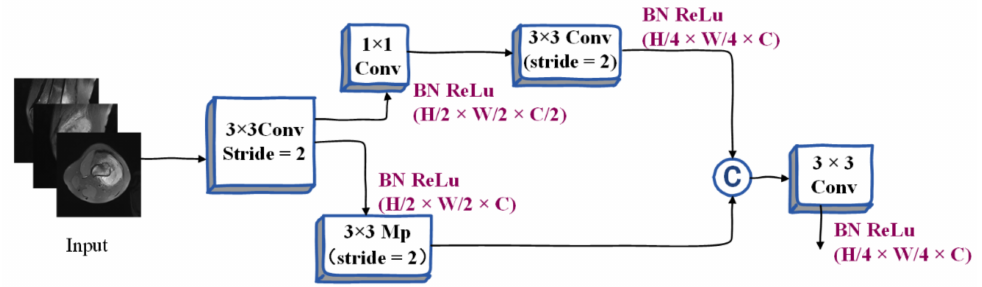
Figure 3. Illustration of Stem Block.